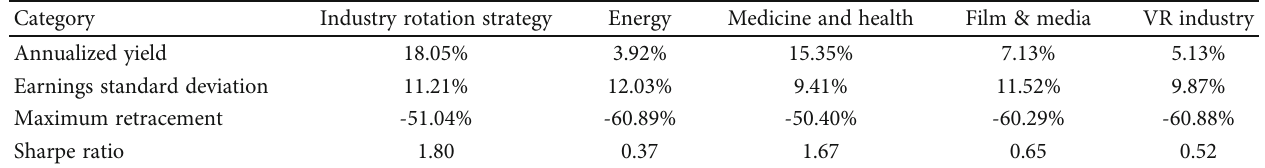
Table 9: Sector rotation strategy model and individual index strategy